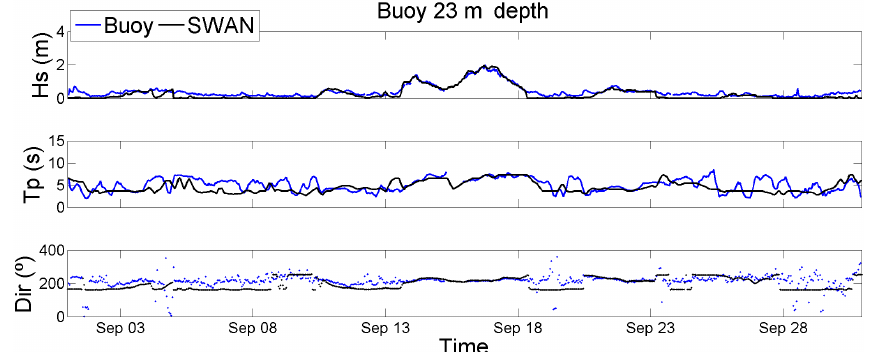
Figure 10. H s , T p and wave direction as modelled by the SWAN model and observed at the buoy deployed at 23m depth in Playa de Palma.